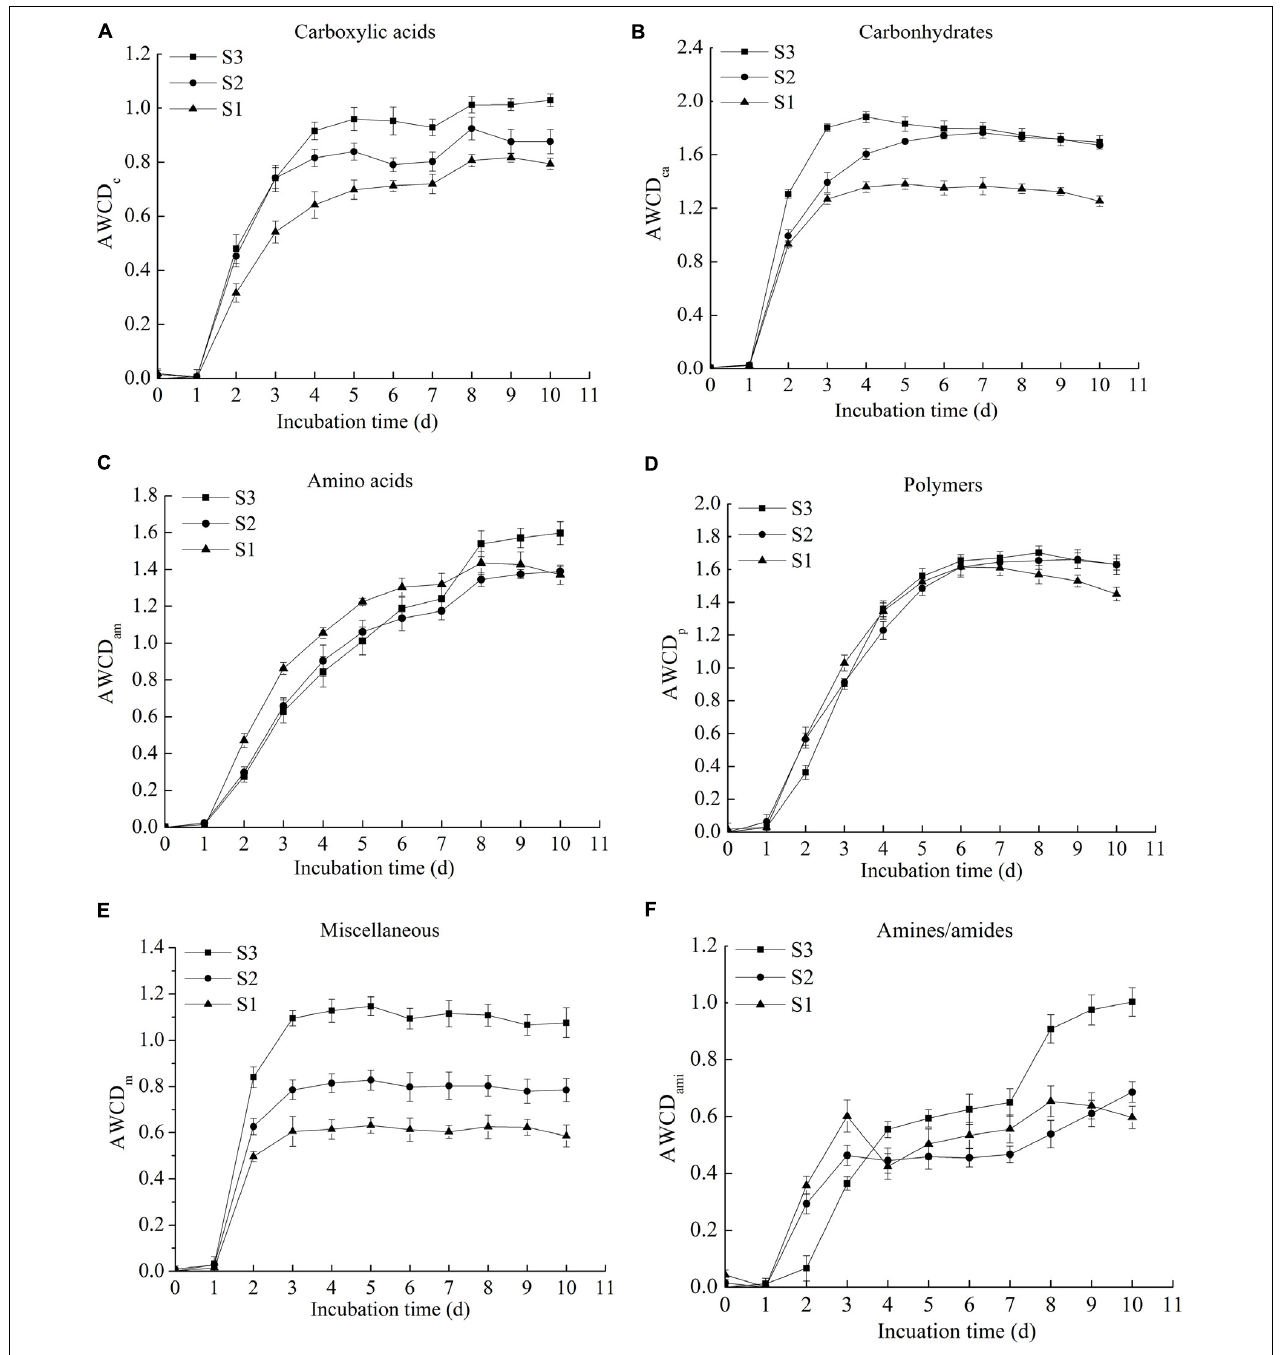
FIGURE 2 | The AWCD of six types of carbon sources in three stored rice microbial communities, including carboxylic acids (A) , carbohydrates (B) , amino acids (C) , polymers (D) , miscellaneous (E) , and amines/amides (F) (the original data available in Supplementary Table